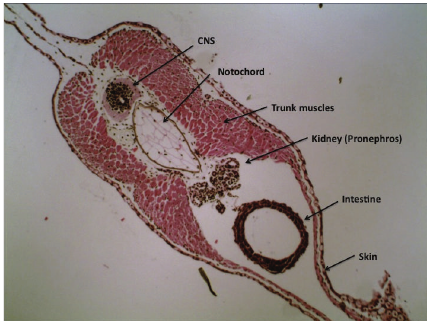
Figure 2: Histological cross section of the body of a healthy 10- week-old larva axolotl (H&E stain, 10x). Note the clear appearance of the intestinal lumen and compactness of the gut wall.